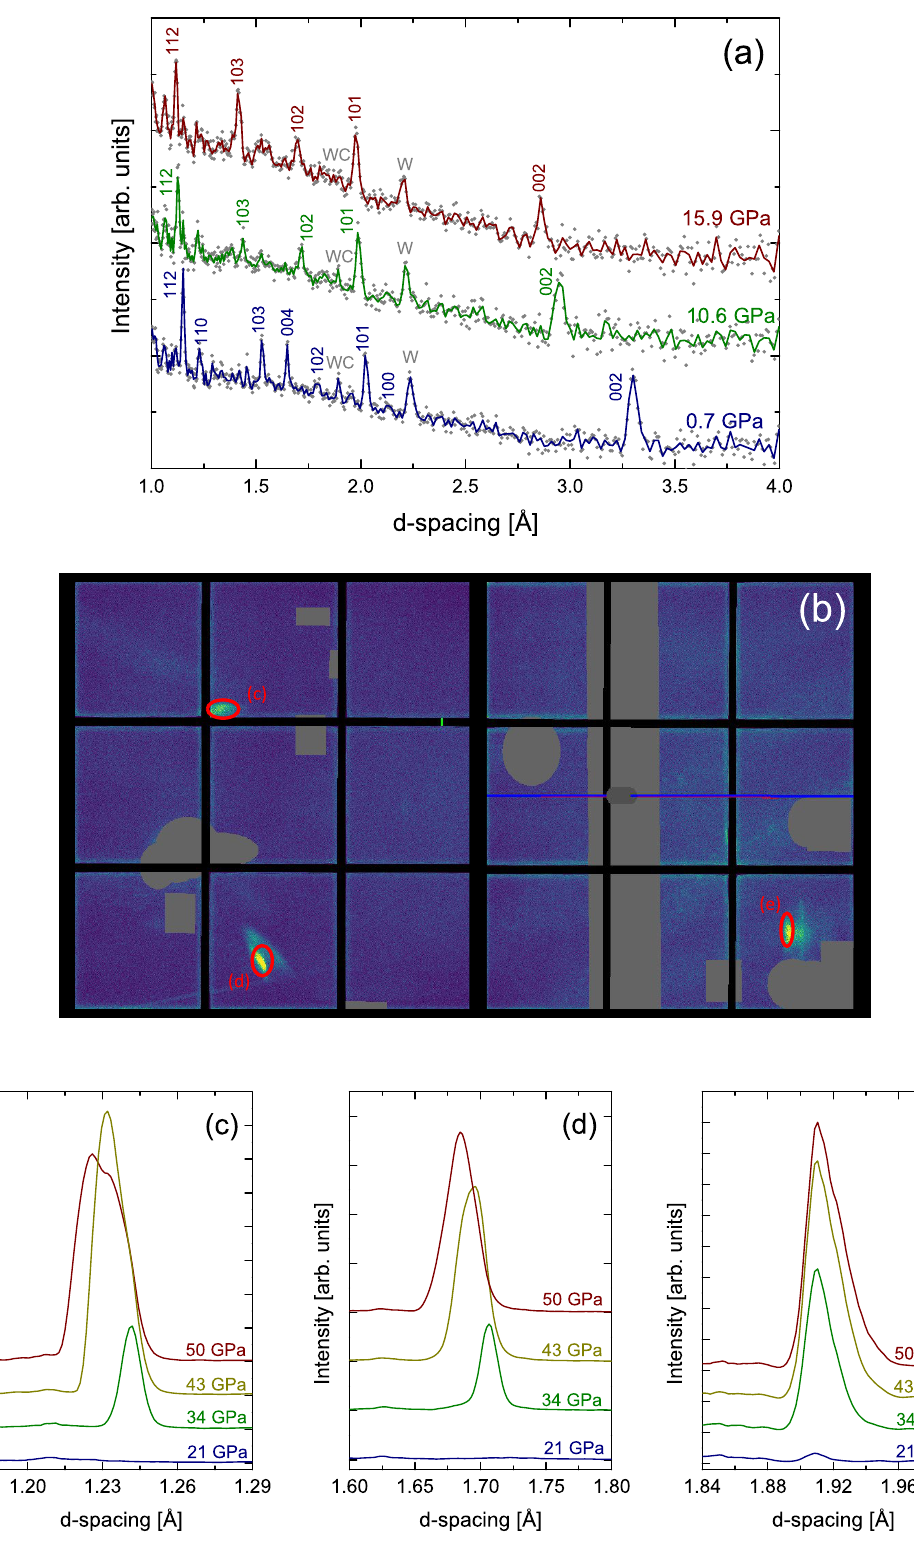
Figure 4. High pressure neutron diffraction of graphite loaded with Ar pressure medium. ( a ) Powder diffraction patterns from ambient pressure close to 16 GPa indexed based on graphite’s hexagonal unit cell, P 6 3 / mmc . Finely binned data are shown by (grey) circles and the solid lines show more coarsely binned data for clarity. ( b ) 2D detector view extracted from MantidWorkbench (V6.1.0, https:// www. manti dproj ect. org/) 41 showing the diffuse single crystal features observed at 50 GPa in a d -range of 1.1–2.1 Å. Cell backgrounds such as single crystal diamond peaks are masked (greyed out areas). The areas integrated for each individual single crystal feature are indicated by red circles. This was performed in the exact same detector location for each pressure from 21–50 GPa. The pressure evolution of the three peaks is shown in ( c – e